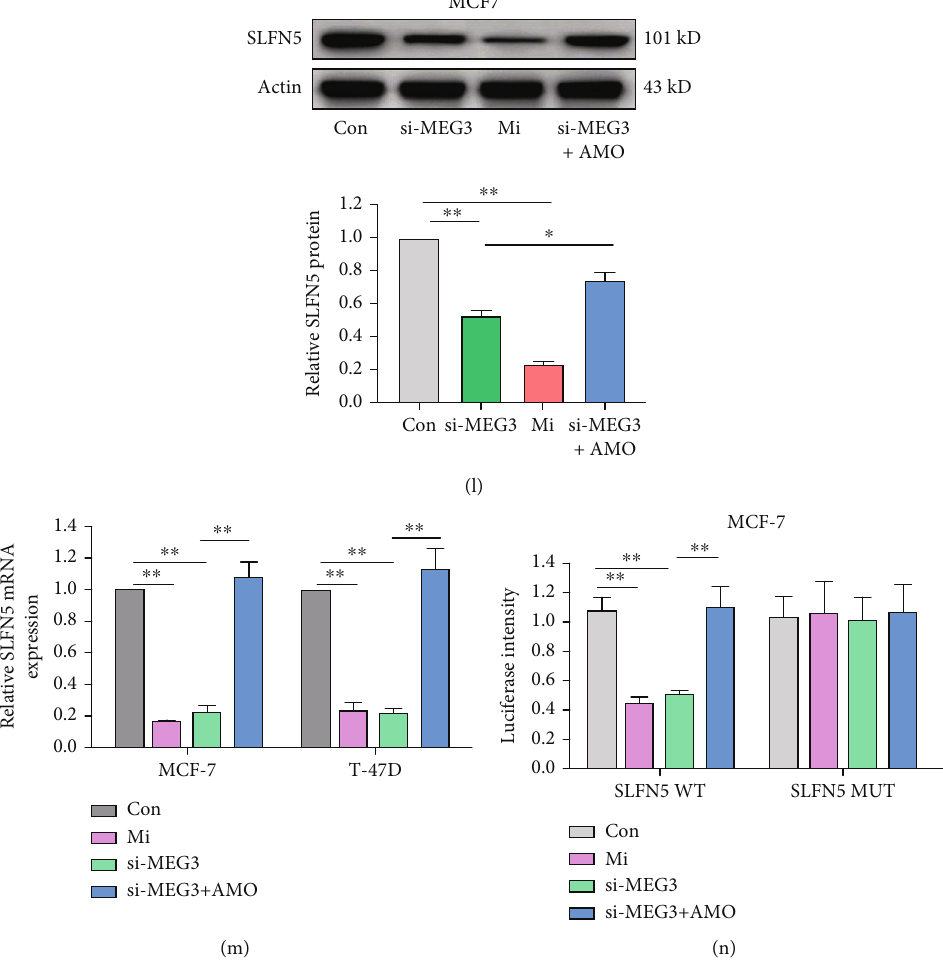
Figure 4: MiR-146b-5p could bind to MEG3 and SLFN5 3 ′ UTR directly by competing endogenous RNAs mechanism. (a, b) Twelve miRNAs predicted to regulate both SLFN5 and MEG3 by bioinformatics. (c, d) Comparison of 12 miRNA expression between control group and si-MEG3/MEG3 group in BRCA cell lines. (e) Schematic representation of binding sites between MEG3 and miR-146b-5p predicted by RNAhybrid. WT: wild type. MUT: mutant. (f) miR-146b-5p expression change in MCF7 cells after MEG3 plasmid transfection. (g) MEG3 expression change after transfection of either mimic (Mi) or inhibitor (AMO) of miR-146b-5p. (h) Luciferase reporter assay in 293T cells after transfection with MEG3 plasmids, either wild type (WT) or mutant (MUT), and Mi of miR-146b-5p. (i) RNA pull down assay of MEG3 binding to miR-146b-5p in MCF7 cells. (j) Schematic representation of binding sites between miR- 146b-5p and SLFN5 ’ s 3 ′ -UTR predicted by RNAhybrid. (k) Relative mRNA levels of SLFN5 responding to transfection of either mimic (Mi) or inhibitor (AMO) of miR-146b-5p. (l, m) Relative change of SLFN5 protein and mRNA responding to transfection of si-MEG3 or miR-146b-5p Mi or si-MEG3 plus miR-146b-5p inhibitor. (n) Luciferase reporter assay of transfection with SLFN5 plasmid, either WT or MUT, and miR-146b-5p Mi, or si-MEG3, or si-MEG3 plus miR-146b-5p AMO